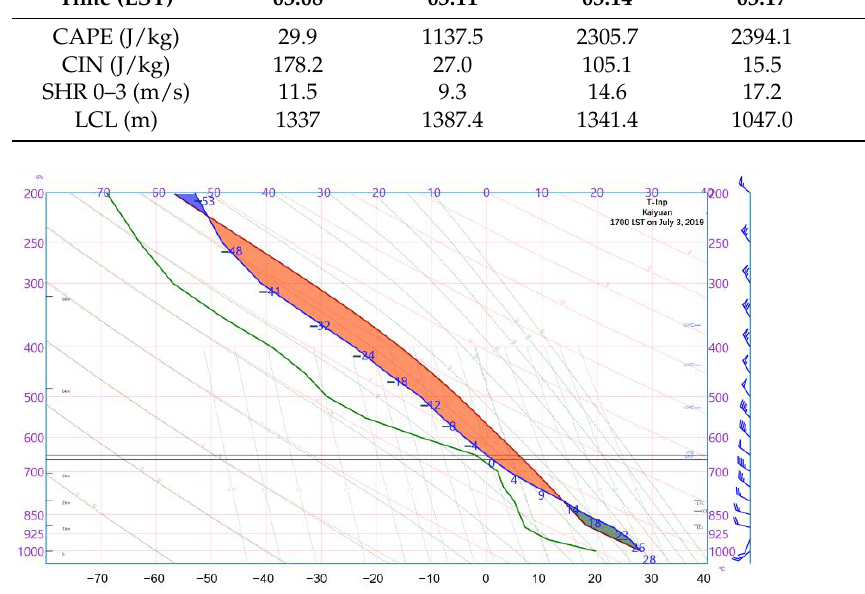
Figure 14. The 17:00 LST Kaiyuan T-lnp from the WRF simulations in Domain 2 and surface observations. A full bar is 4 m · s − 1 .